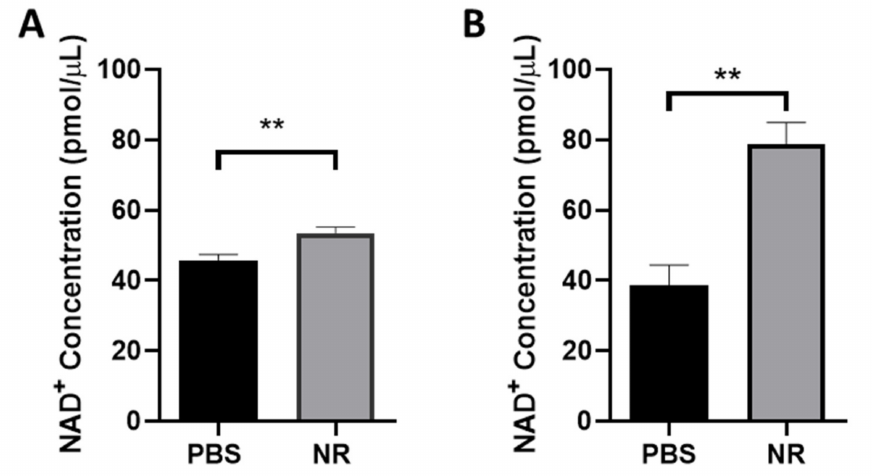
Figure 1. NR treatment increased retinal NAD + levels in DBA/2J mice and C57BL/6J. Mice were i.p. injected with 1000 mg/kg NR or PBS for 5 consecutive days. One to two hours after the last injection, mice were euthanized and retinas harvested. NAD + was measured by colorimetric assay. Retinal NAD + levels from mice treated with NR were statistically significantly increased compared to vehicle (PBS) treated group. ( A ). NAD + level comparison with and without NR treatment in DBA/2J mice. ( B ). NAD + level comparison with and without NR treatment in C57BL/6J mice. ** p < 0.01 by Student’s t-test. N = 7–10 retinas/group. Error bars represent